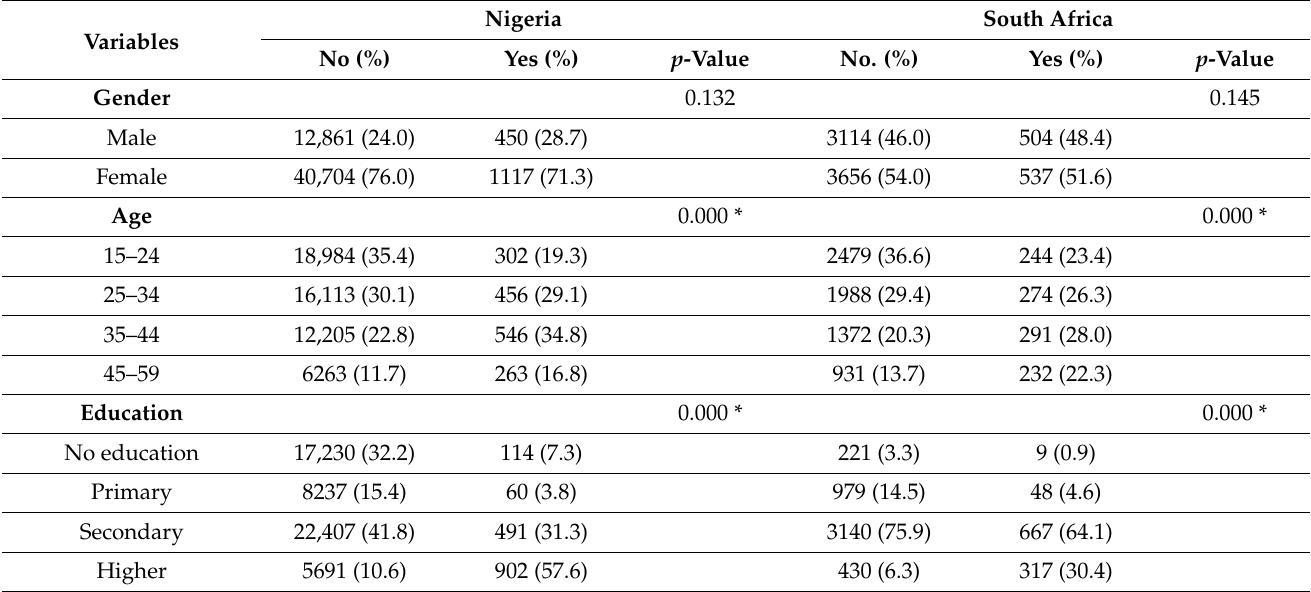
Table 3. Distribution of health insurance coverage by socio-demographic characteristics in South Africa and Nigeria.